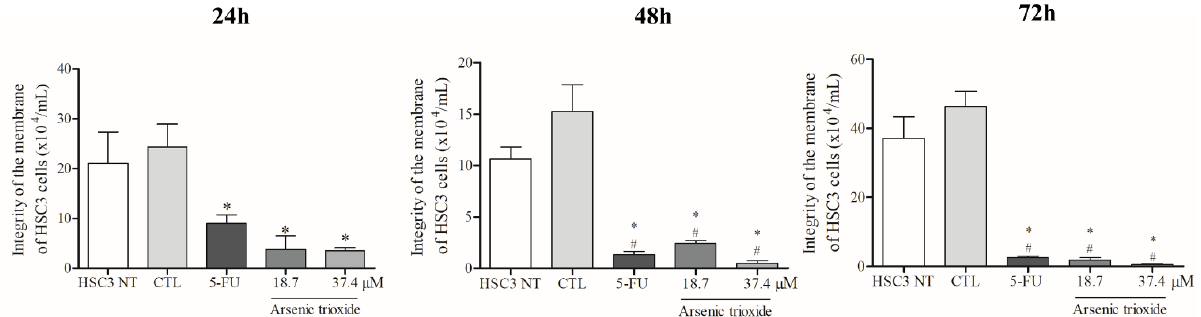
Figure 1. The cytotoxic effect of ATO on membrane integrity of HSC3 cells. Numbers of cells with integrity of membrane correspond to mean ± SEM of three independent experiments carried out in duplicate. (*) p ≤ 0.05 compared to the negative control (CTL), and (#) when compared to the HSC3 NT group (non-treated cells) by ANOVA (analysis of variance) followed by Student Newman-Keuls test.